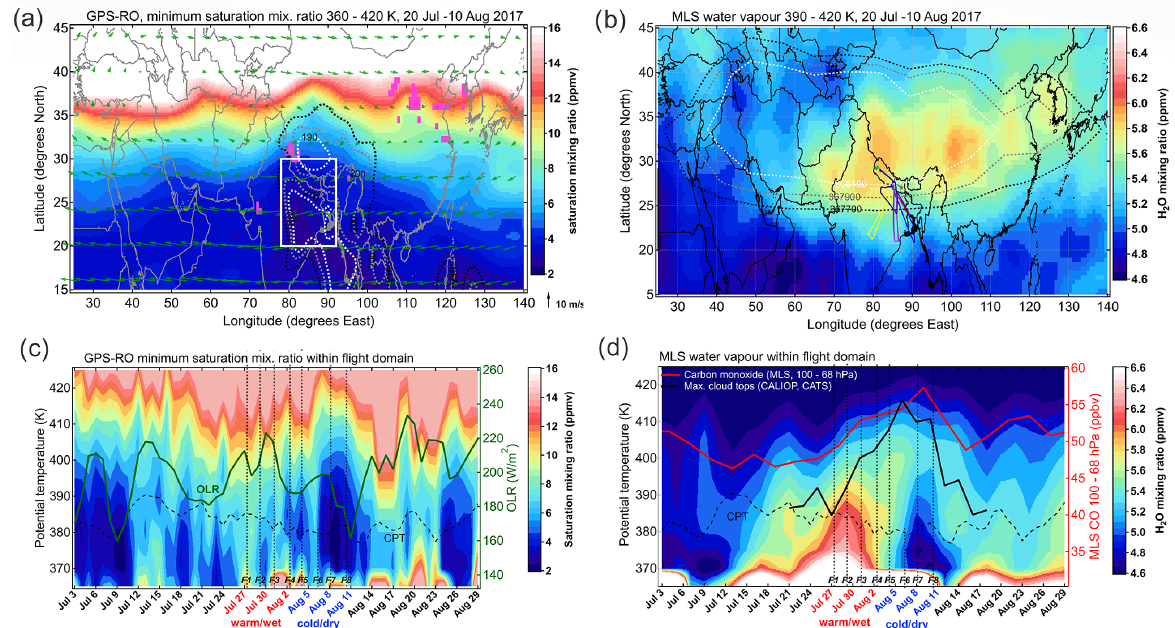
Figure 1. Overview and evolution of AMA UTLS conditions during July–August 2017 from satellite observations. (a) Colour map shows the GPS-RO minimum saturation mixing ratio (ppmv) encountered within the 360–420K layer during the 20 July–10 August period. Dashed contours indicate National Centers for Environmental Prediction (NCEP) OLR (Wm − 2 ) in the range 190–210Wm − 2 (contour interval 10Wm − 2 ). Green arrows are wind velocity vectors (ERA5, 70–100hPa average for the campaign period). Pink pixels mark the most probable sources of the hydrated features (see Sect. 4.2). White rectangle indicates the flight domain. (b) Horizontal distribution of MLS water vapour in the confined LS (390–420K layer) averaged over the 20 July–10 August period with the date-coloured flight tracks superimposed (see Fig. 2 for colour definition). Dashed contours depict the Montgomery stream function (m − 2 s − 2 ), which is used to define the horizontal boundaries of the AMA at 390–410K levels (Santee et al., 2016). (c) Evolution of the GPS-RO minimum saturation mixing ratio profile within the flight domain (20–30 ◦ N, 78–92 ◦ E). Green curve plotted versus right-hand axis depicts the domain-mean OLR. (d) Evolution of the MLS water vapour profile within the flight domain. The solid black curve depicts the maximum level of cloud tops detected using CALIOP and CATS satellite lidars. The red curve indicates MLS carbon monoxide (68–100hPa mean). The vertical dashed lines indicate the flight dates (flight number is given as F x ) and their vertical extent, and the dashed curve marks the average CPT potential temperature level (GPS-RO) in both panels (c) and (d)